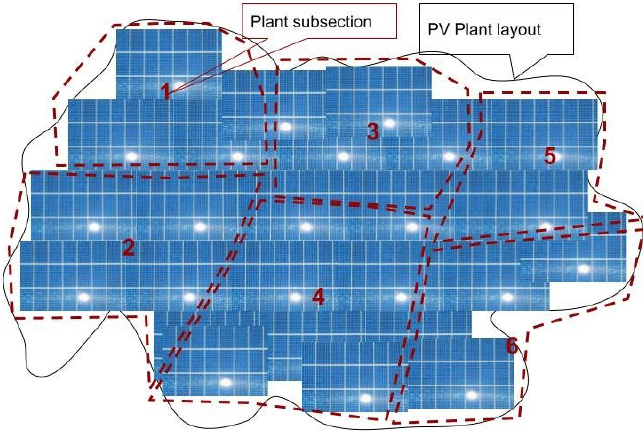
Figure 1. The spatial distribution of PV plants’ layout and data collection